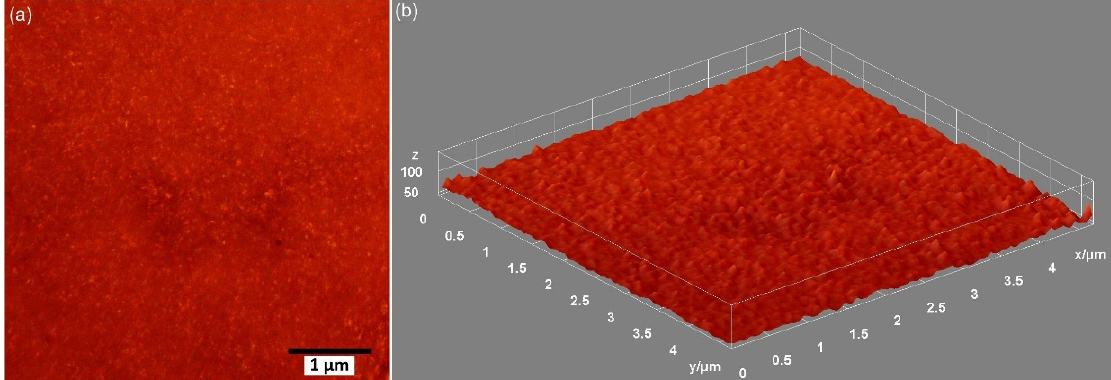
Figure 9. Metallographic images in 2D ( a ) and 3D representation ( b ) typical for N and Br co-doped HAp thin films deposited on the glass substrate.